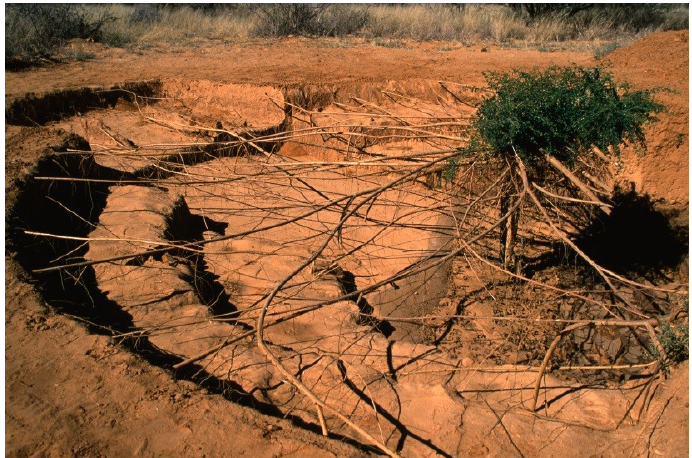
Figure 1. The root network of an encroacher bush that prohibits grass growth within its vicinity and prevents water from reaching groundwater wells